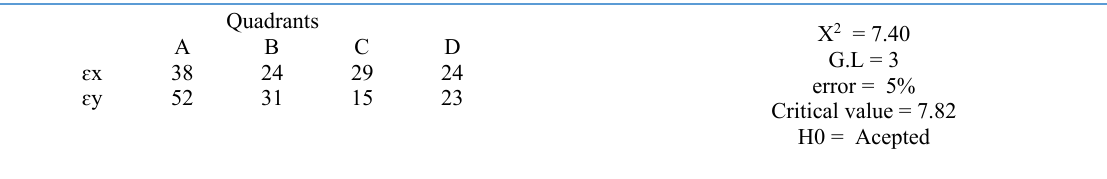
Table 2 - On the left, deformation frequency ɛ x and ɛ y by quadrants A, B, C and D, on the right the parameters ANOVA, X 2 - standard deviation, G.L - degree of freedom, H0 - chi-square